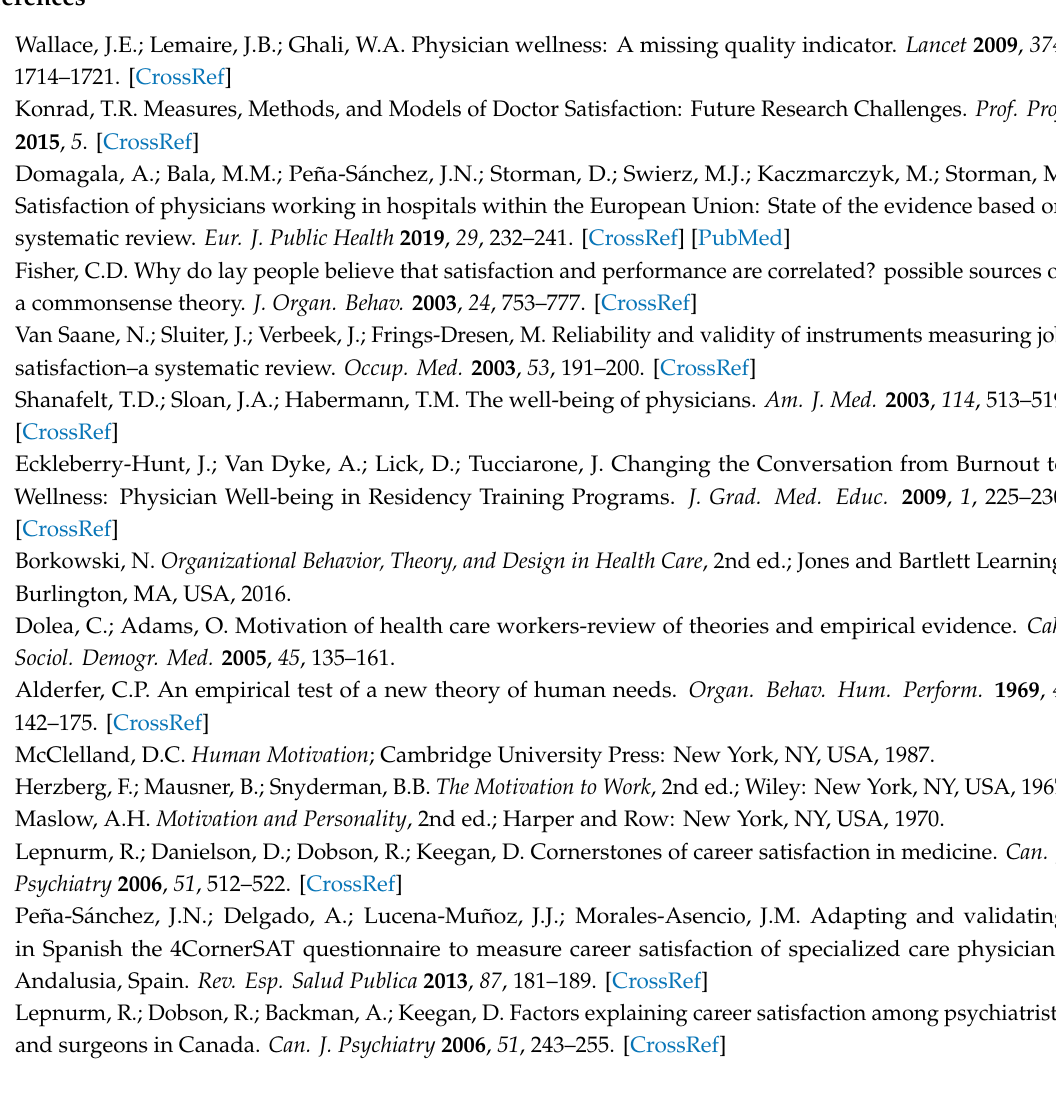
s1, Table S1: Polish version of the 4CornerSAT questionnaire, and Table S2: English version of the 4CornerSAT